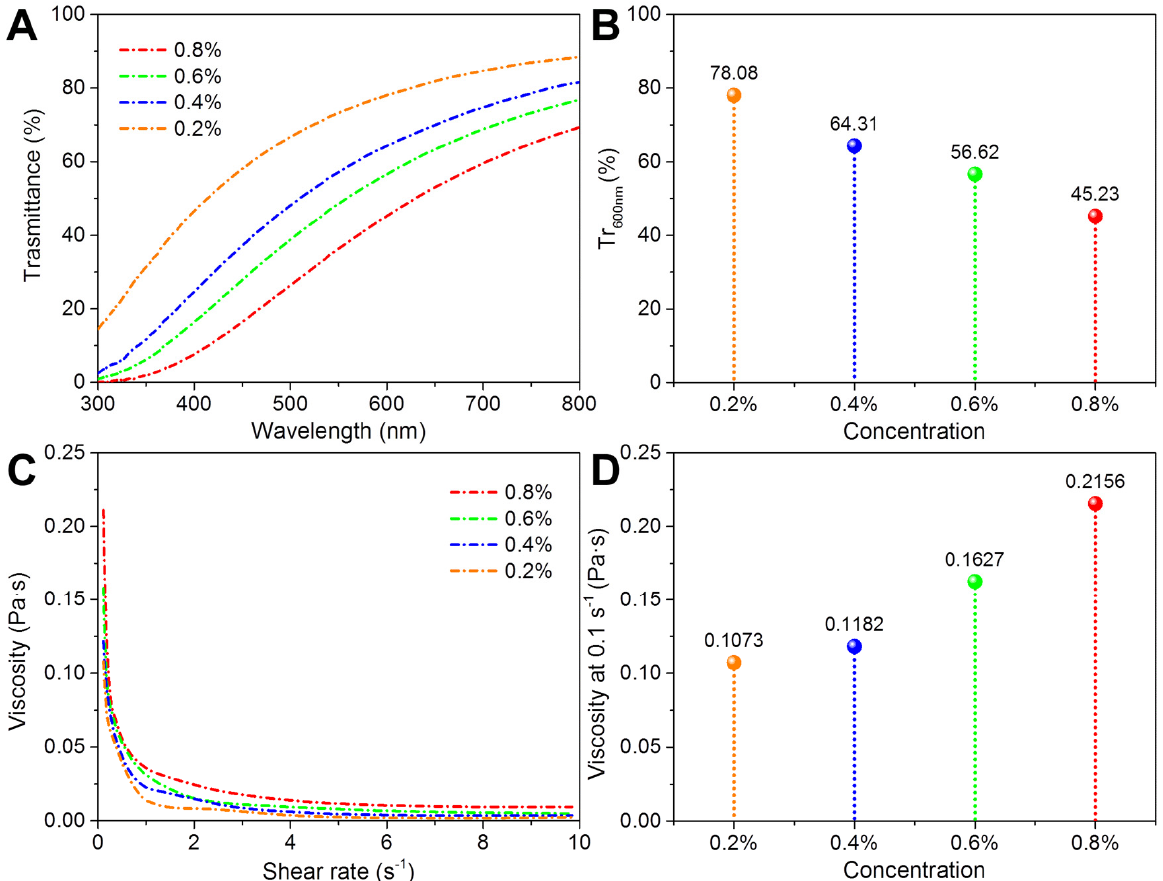
Figure 3. Light transmittance scanning curves ( A ), light transmittance at 600 nm ( B ), apparent viscosity shear curves ( C ), and the apparent viscosity at 0.1 s − 1 ( D ) of the prepared nano chitin dispersions with different concentrations.